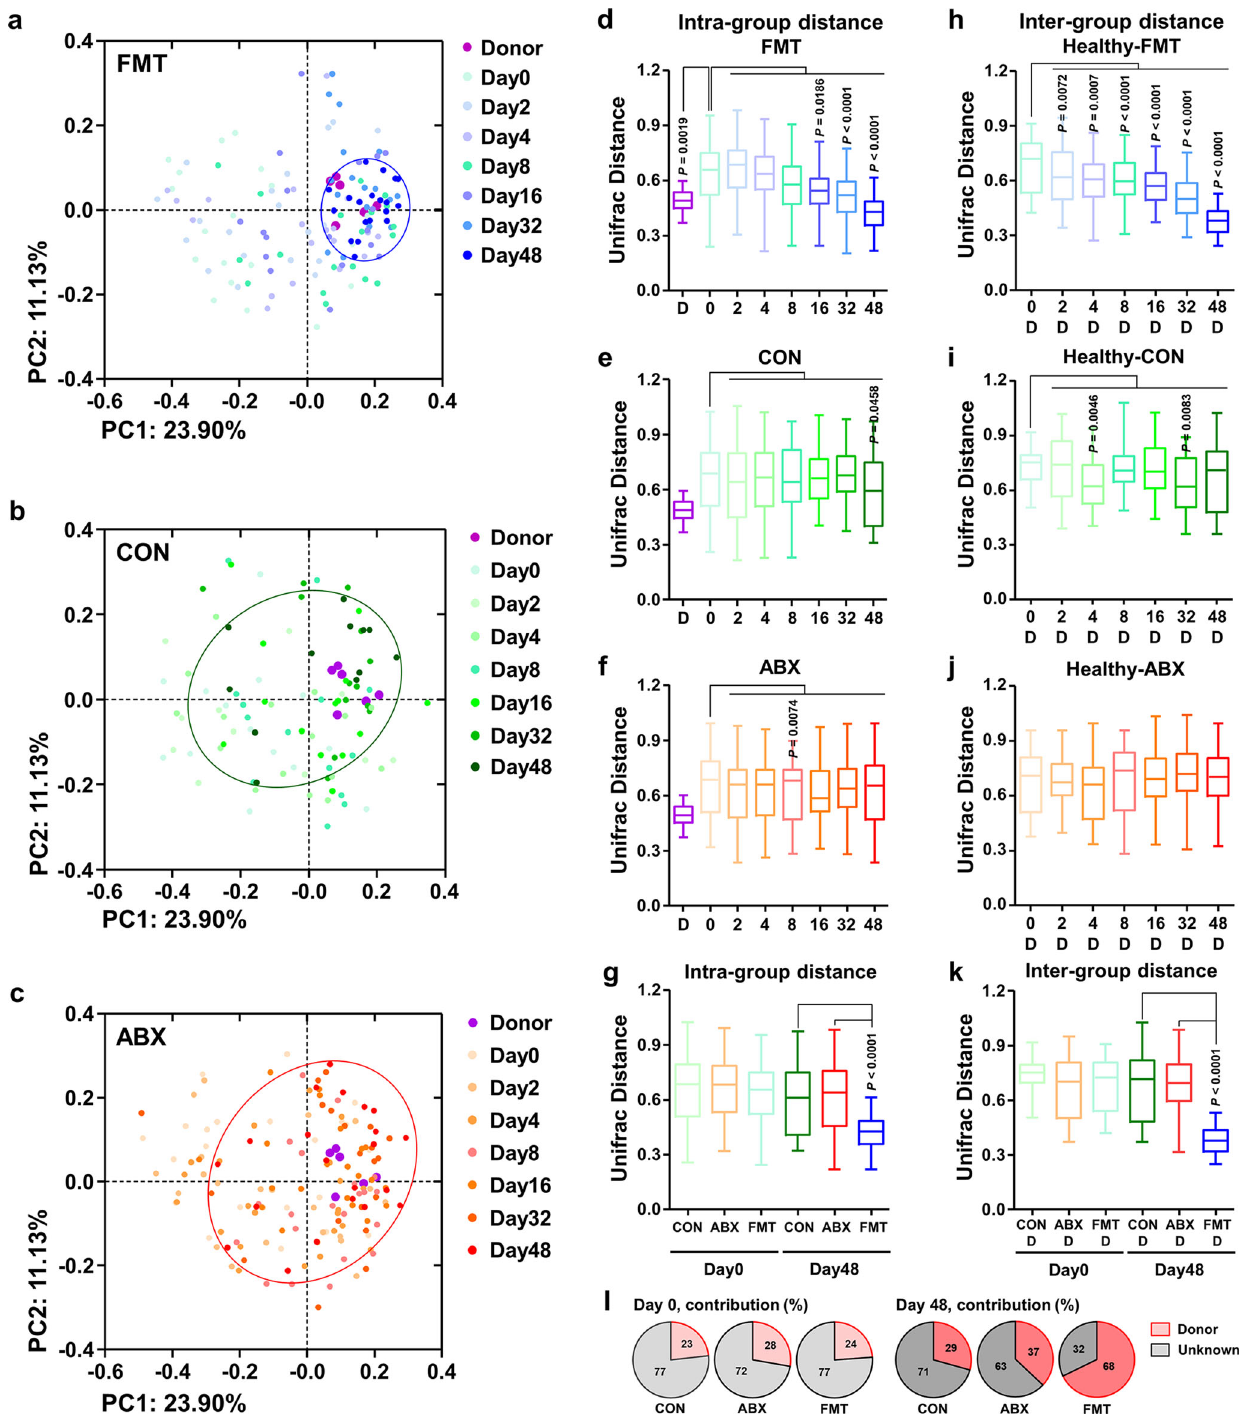
visualized using a heatmap (Fig. 4c). The concentrations of several amino acids (alanine, leucine, valine, isoleucine, glycine, arginine, ornithine, and glutamic acid) were relatively low in the day 48 FMT calves when compared with those in the day 48 CON and ABX calves (Supplementary Fig. 6). Indeed, these relative amounts had signi fi cantly decreased from baseline only in FMT calves before the 48 day time point (Fig. 4d). By contrast, there were relatively higher concentrations of several amino acids (alanine, valine, isoleucine, and glycine) 48 days after treatment commenced in the CON and ABX groups. Therefore, we